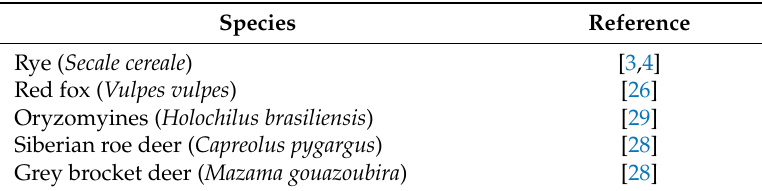
Table 2. Isolation of B chromosomes by flow